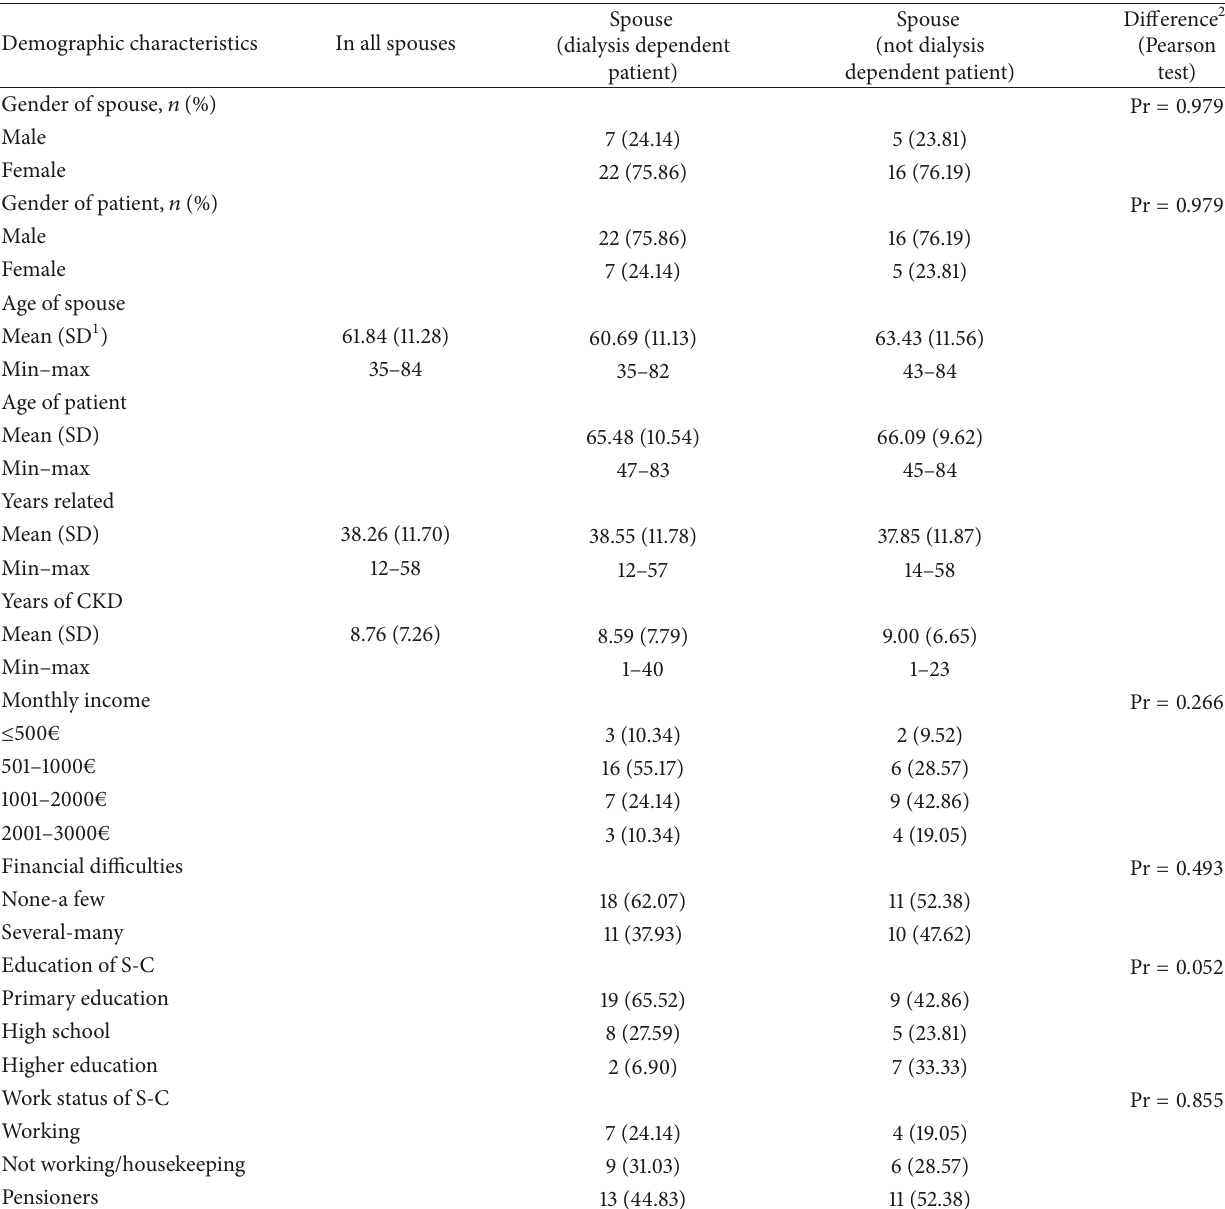
Table 1: Demographic characteristics of spouse caregivers (S-C) and spouse patients (S-P) with chronic kidney disease (CKD) in two groups. Demographic characteristics